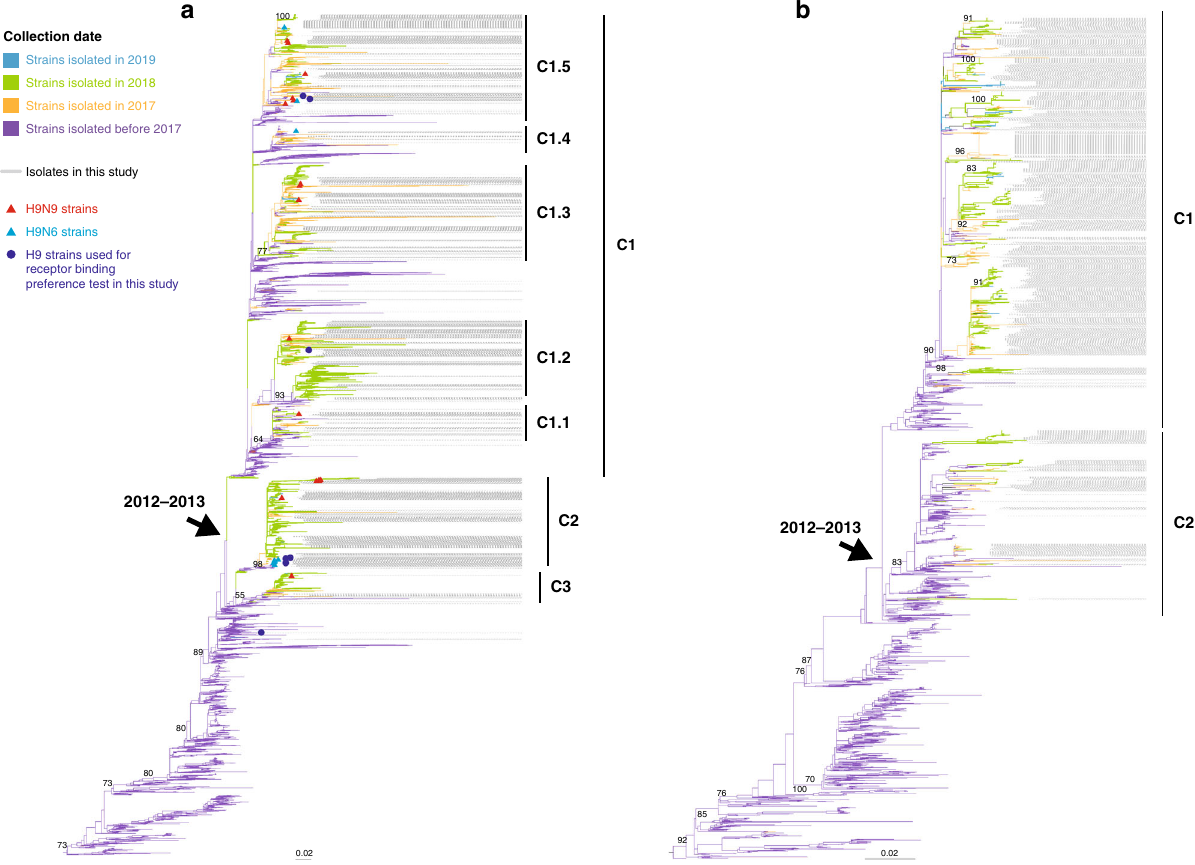
Fig. 3 Phylogenetic analysis of the HA gene of H9Ny AIVs and the NA gene of H9N2 AIVs. a Phylogenetic tree of the HA gene of H9Ny AIVs. b Phylogenetic tree of the NA gene of H9N2 viruses. Viruses are marked with different colors according to the collection dates (before 2017: blue violet, in 2017: orange, in 2018: light green, and in 2019: light blue). Both trees are rooted using CK/BJ/1/1994(H9N2). The light blue and red triangles represent H9N6 and H9N9 viruses, respectively. All blue dots in the phylogenetic trees ( a ) represent H9N2 and H9N9 strains used for the receptor-binding test in this study. The labels with gray lines indicate all of the H9 isolates sequenced in this